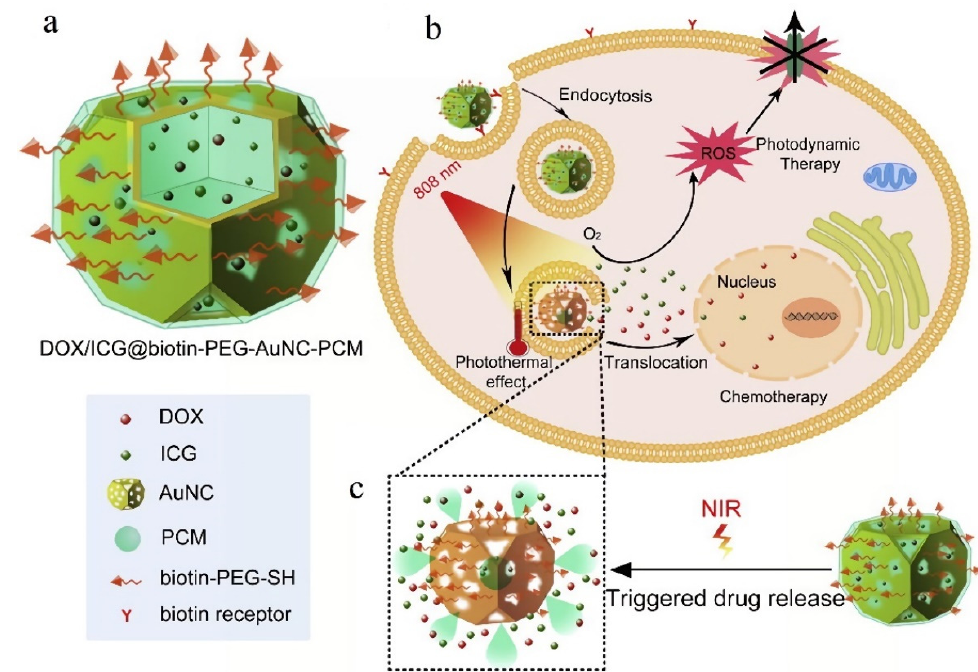
Figure 5. Schematic illustration of ( a ) the structure of DOX/ICG@biotin-PEG-AuNC-PCM nanosystem; ( b ) cellular uptake of DOX/ICG@biotin-PEG-AuNC-PCM by MCF-7/ADR through receptor-mediated endocytosis, intracellular release of ICG and DOX for chemo- and photodynamic therapy; ( c ) NIR-triggered drug release from DOX/ICG@biotin-PEG-AuNC-PCM. Reprinted/adapted with permission from Ref. [66]. Copyright 2017, Acta Materialia Inc. Published by Elsevier